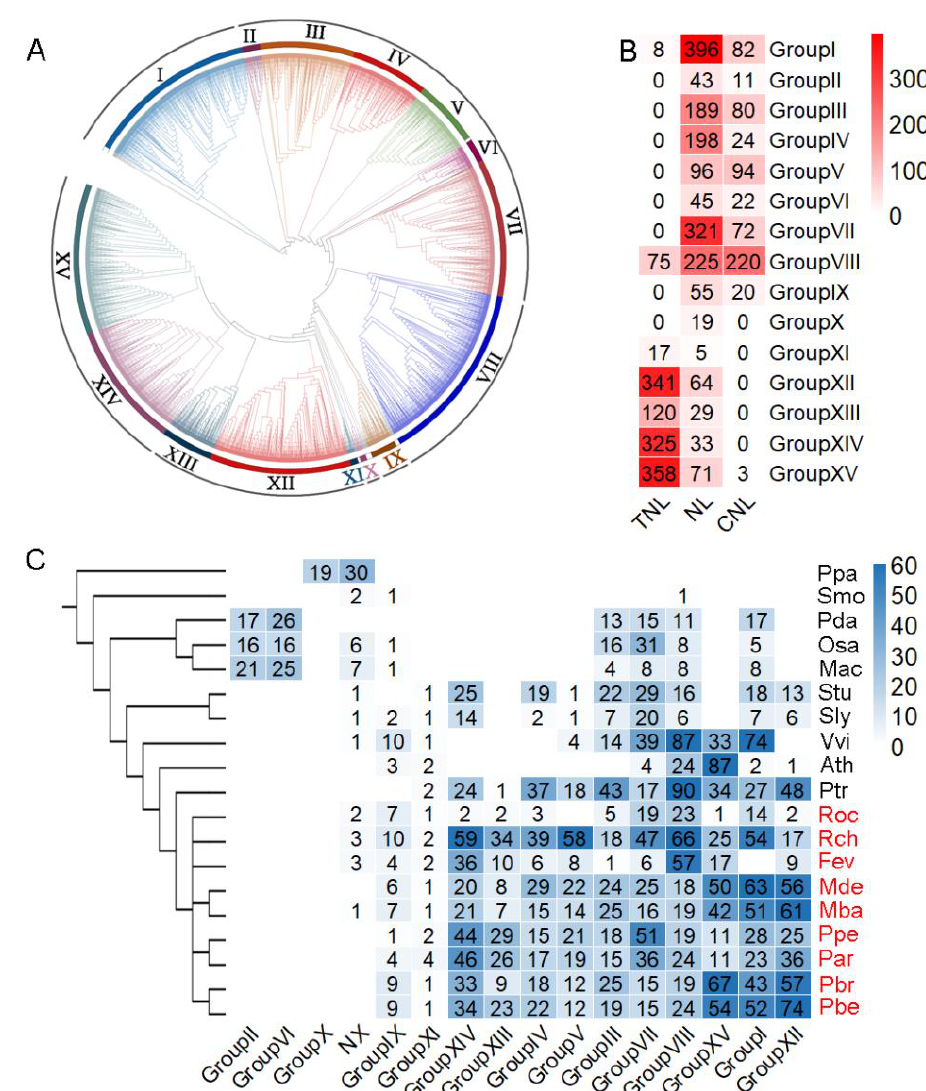
Figure 2. The classification of NLRs. ( A ) A phylogenetic tree was constructed using the full-length amino acid sequences of 3718 NLRs from 19 species. ( B ) The member size of NLR groups in each subfamily. ( C ) The exact member size of NLR groups in each species.